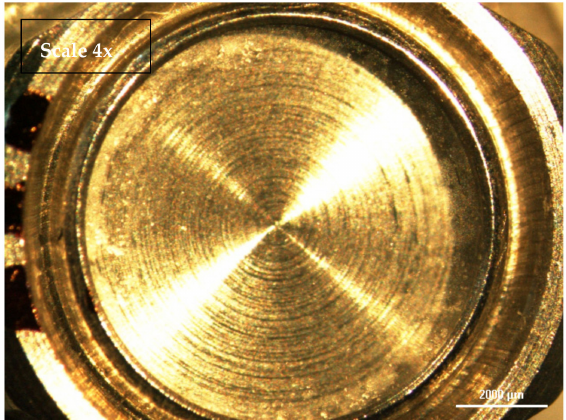
Figure 16. Lower JB on z axis before the test, AISI 316 spindle.